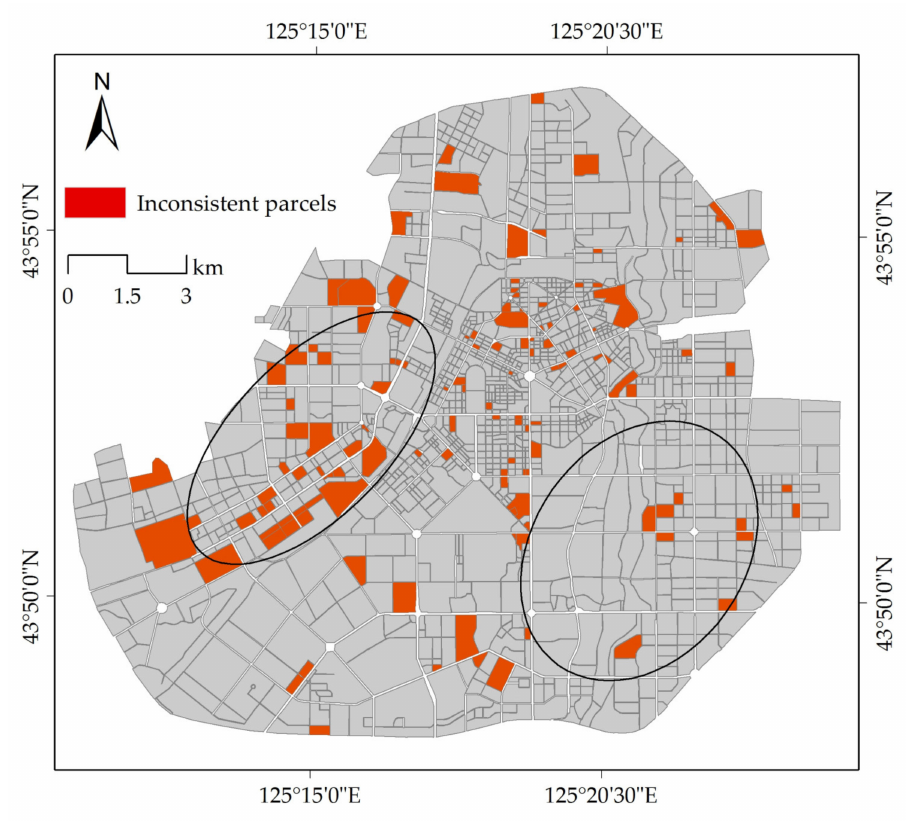
Figure 10. Distribution of inconsistent